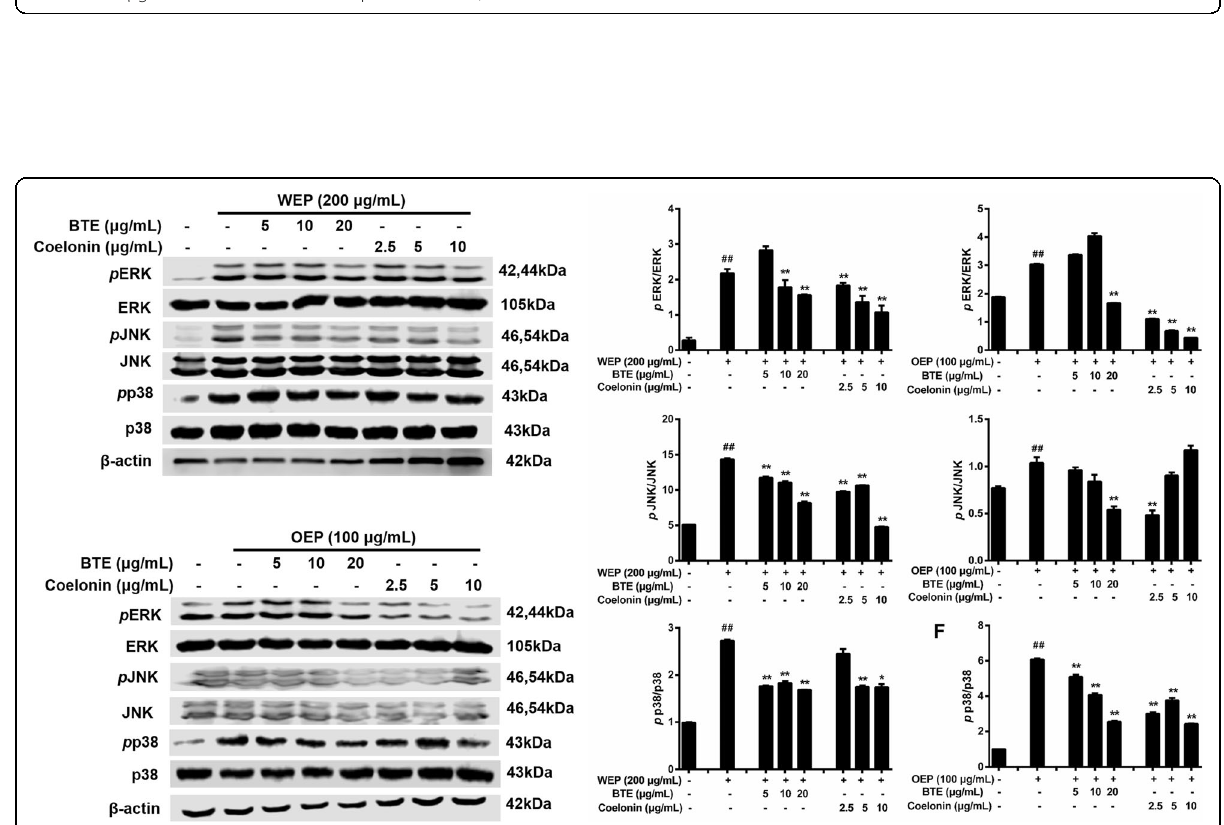
Fig. 8 MAPK pathway activation in RAW264.7 cells after exposure to PM 2.5 extracts. Protein synthesis in RAW264.7 cells exposed to 200 μ g/mL WEP or 100 μ g/mL OEP at different time points. * < 0.05, ** < 0.01 vs.